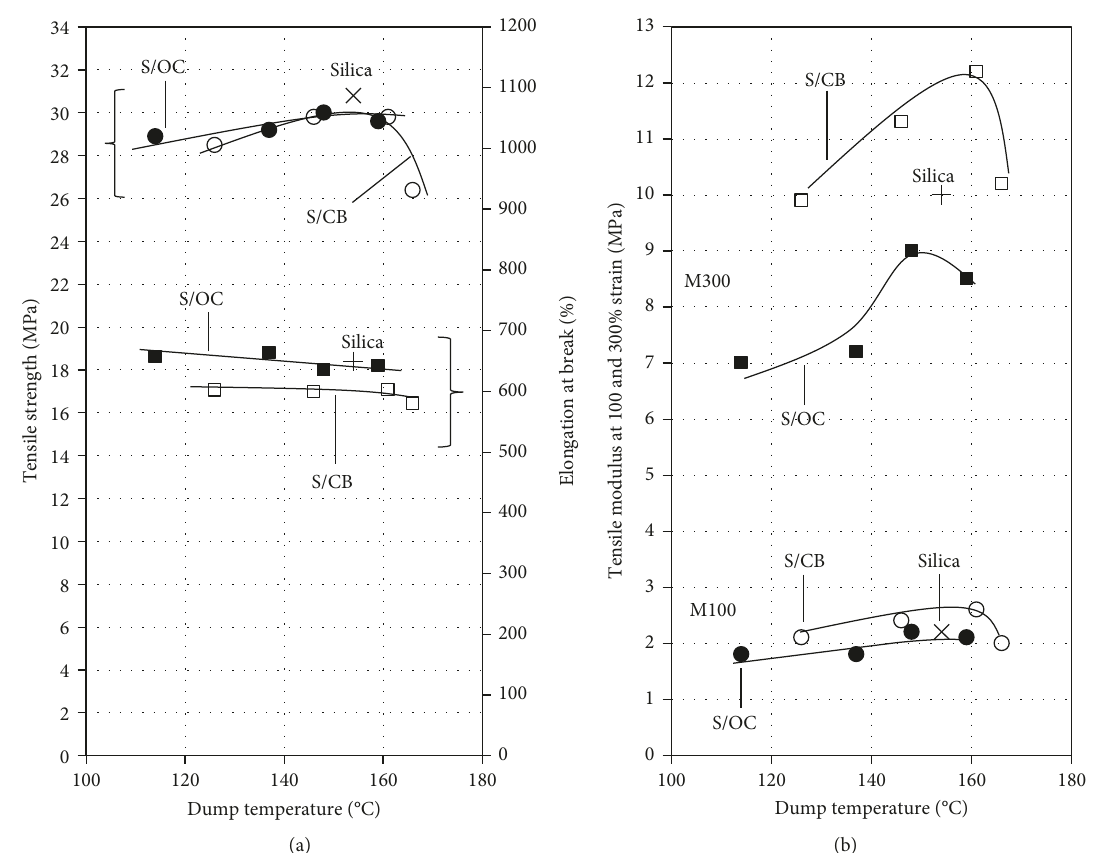
Figure 4: Influence of dump temperature on (a) tensile strength and elongation at break and (b) tensile moduli of the silica-filled NR compounds containing different secondary fillers carbon black (CB) or organoclay